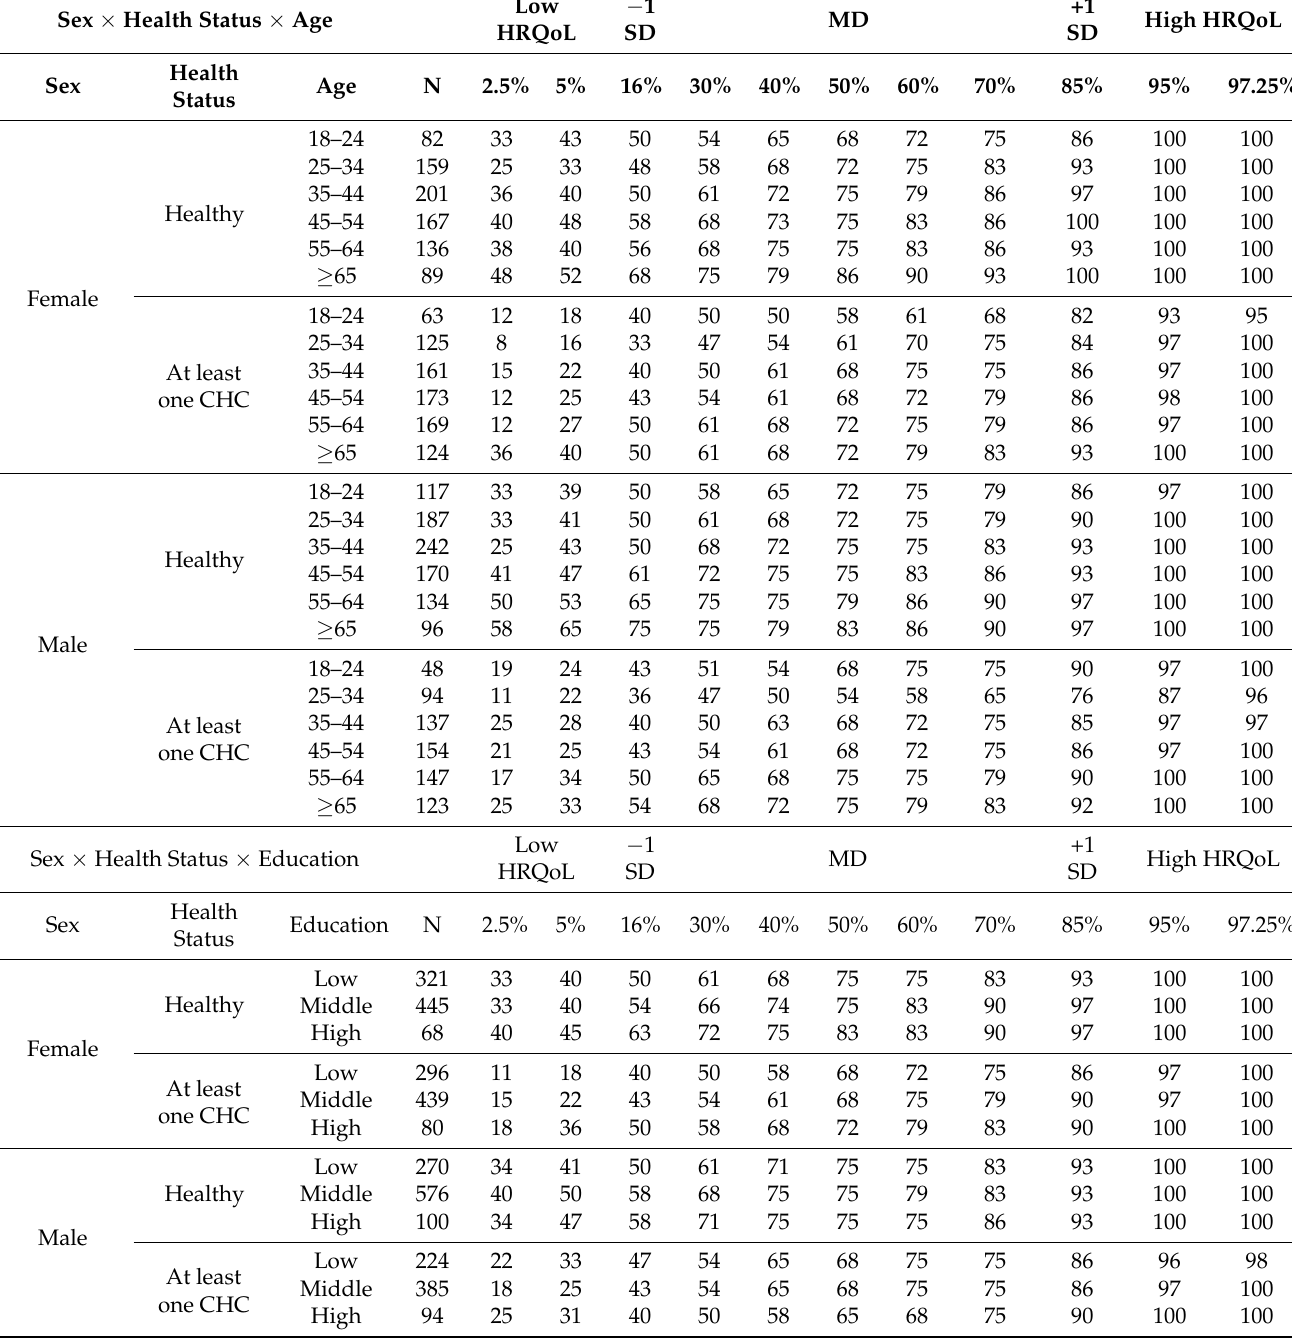
Table A6. Reference values for the QOLIBRI Daily Life and Autonomy scale obtained from the general population sample in Italy stratified by sex, health status, age, and